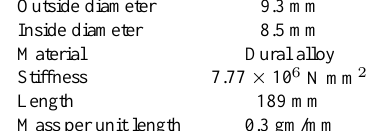
Table 2 Information on the pile